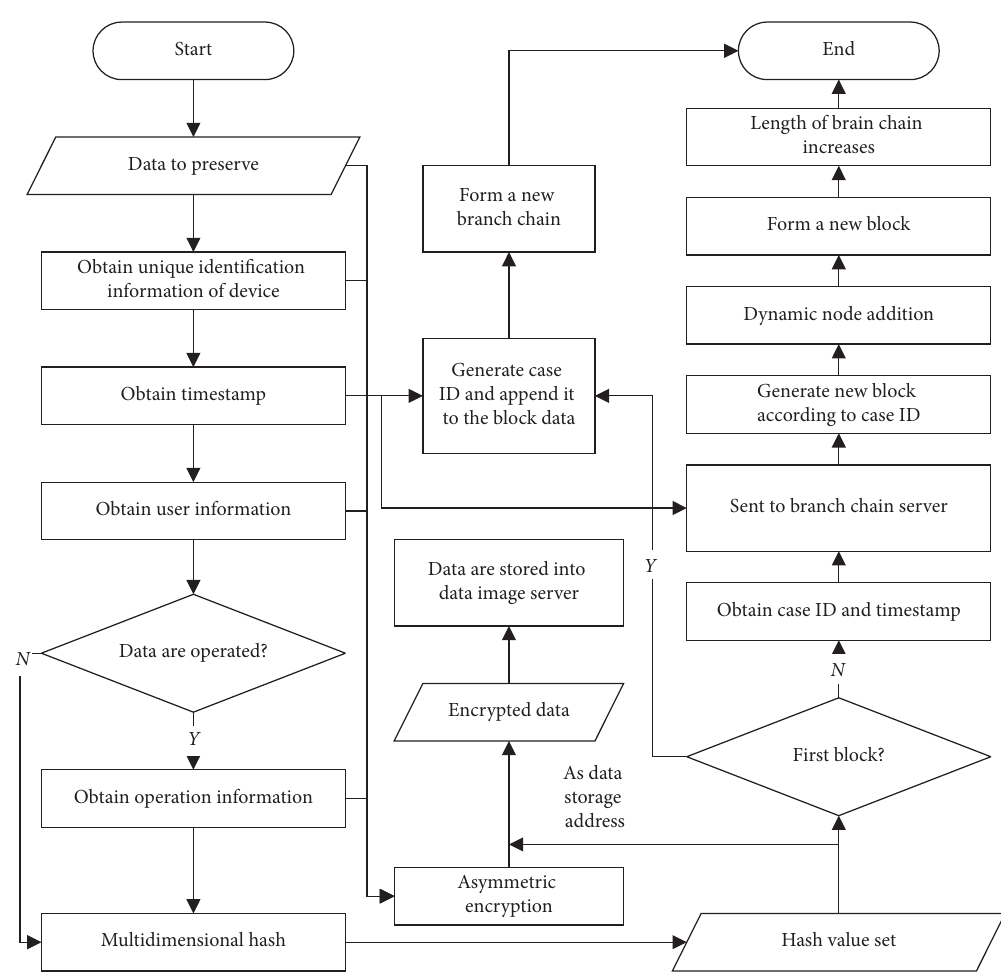
Figure 6: Process of building branch chain.